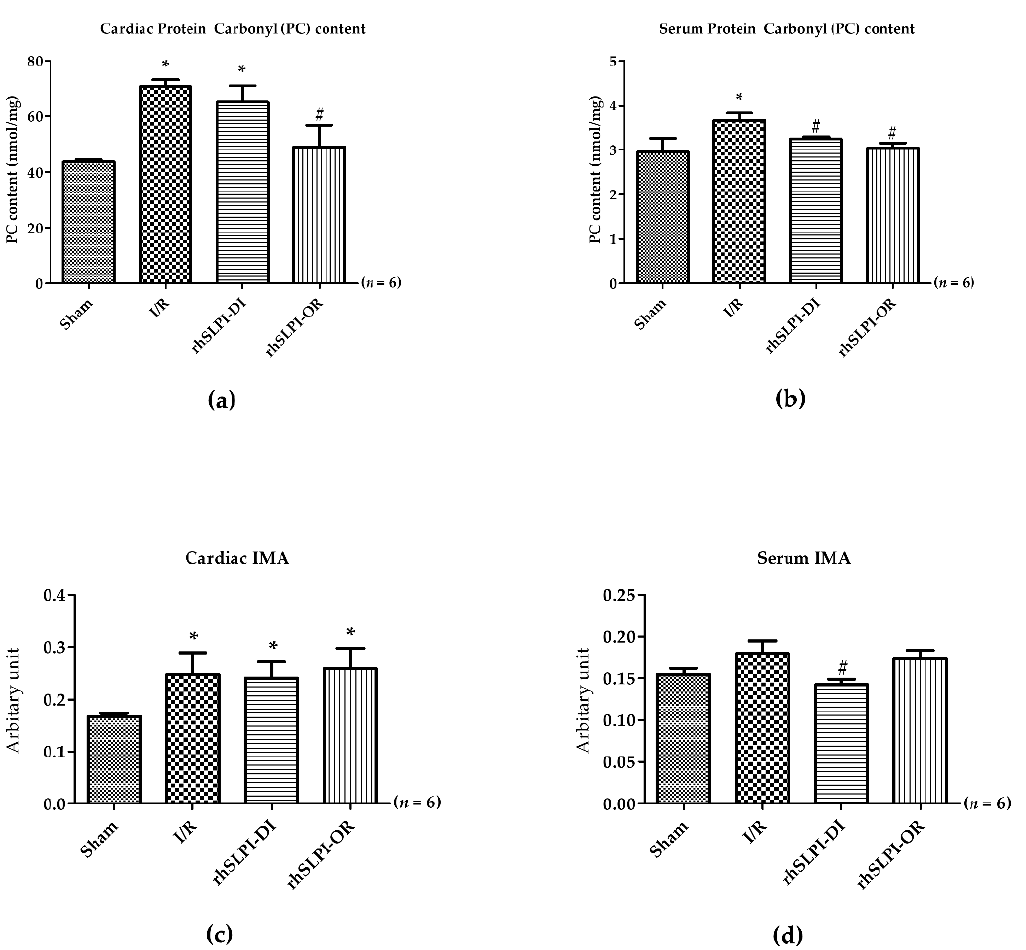
Figure 5. Determination of cardiac ( a , c ) and serum ( b , d ) protein modifications (protein carbonylation and ischemia-modified albumin). (* p < 0.05 vs. sham) ( # p < 0.05 vs. I/R) ( n = 6).